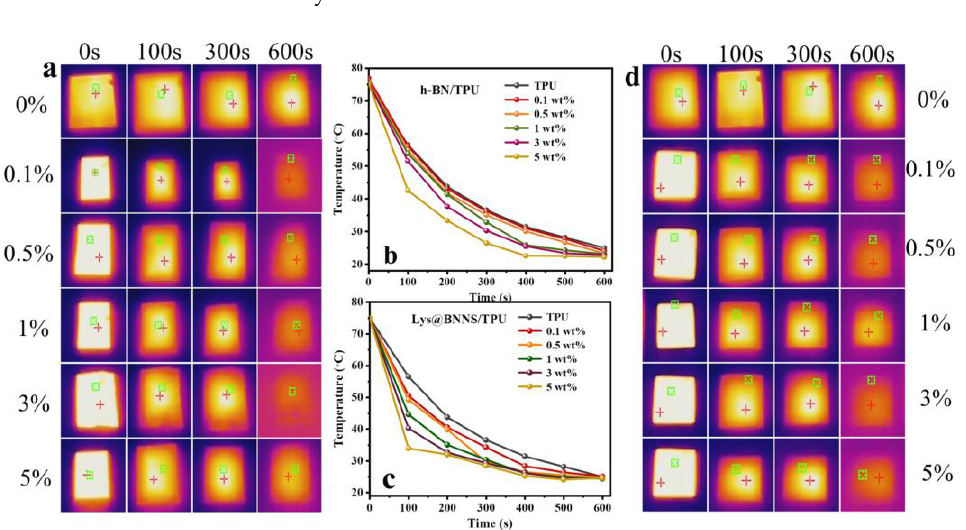
10 of 13 Figure 6. ( a ) Dynamic mechanical analysis storage modulus (E ′ ) and ( b ) loss factor (tan δ) curves of TPU composites.